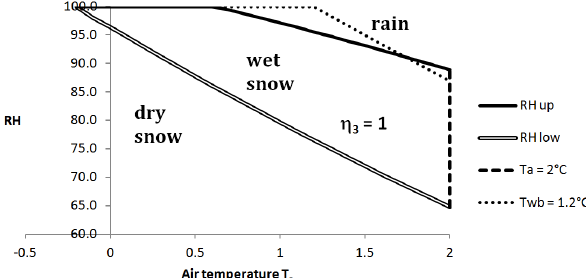
Figure 2. Wet-snow window ( η 3 = 1) in the air temperature ( T a ) and relative humidity (RH)